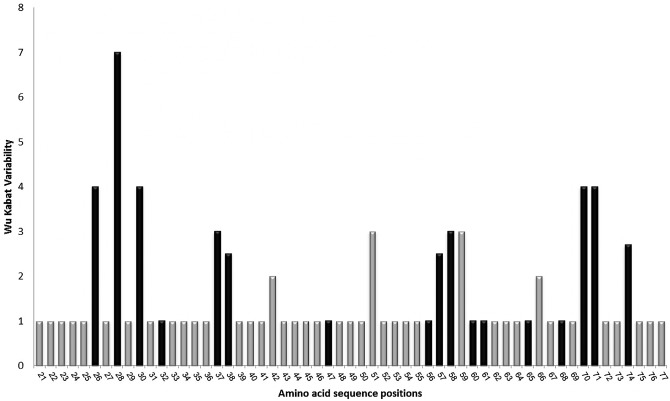
Amino acid variability plot Wu and Kabat for the amino acid residues of the Blue whale DQB allotypes. Darker bars indicate the putative PBR.